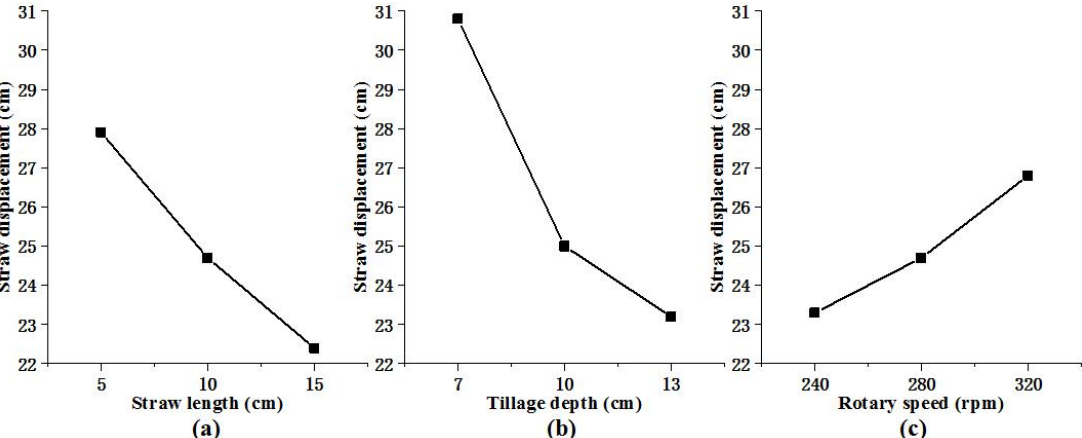
Figure 5. Effect of single factor on straw displacement ( a ) relationship between straw length and straw displacement, ( b ) relationship between tillage depth and straw displacement, ( c ) relationship between rotary speed and straw displacement.